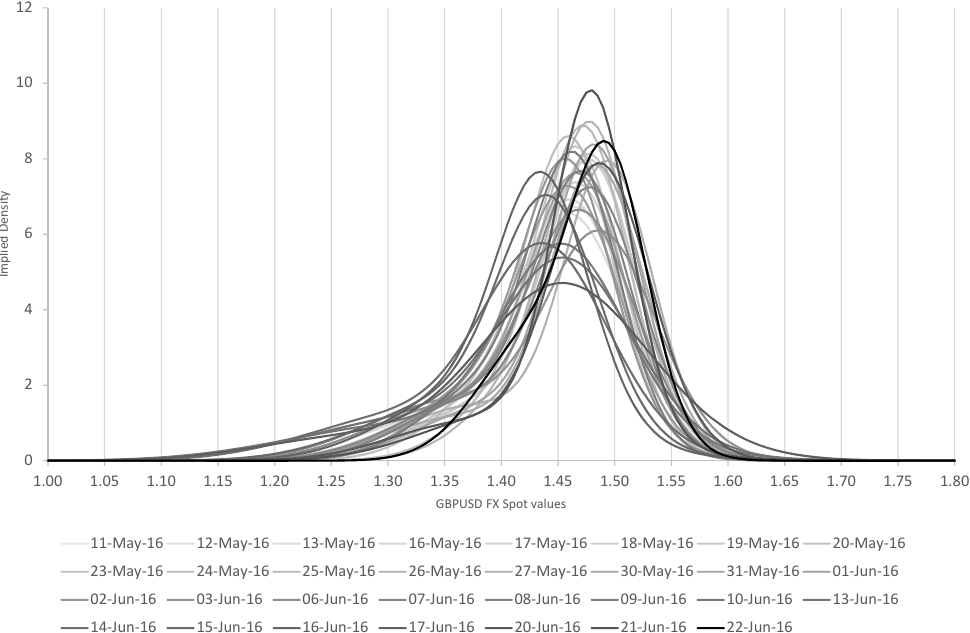
Figure 5. GBPUSD implied densities from the mixture model for the Brexit referendum date from 11 May 2016 to 22 June 2016, sampled daily (in